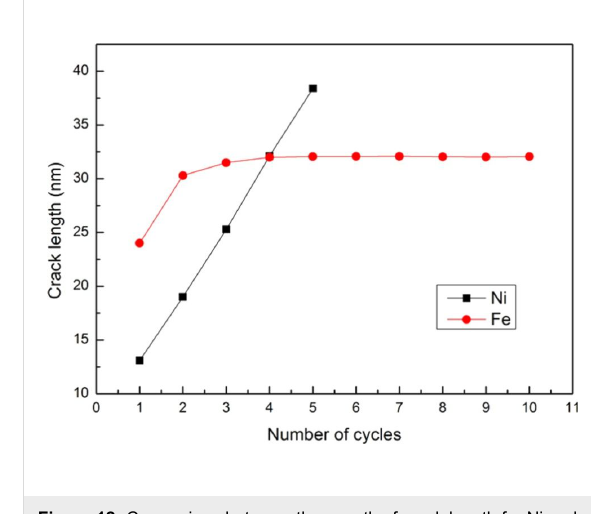
Figure 12: Comparison between the growth of crack length for Ni and Fe under ten times of cyclic